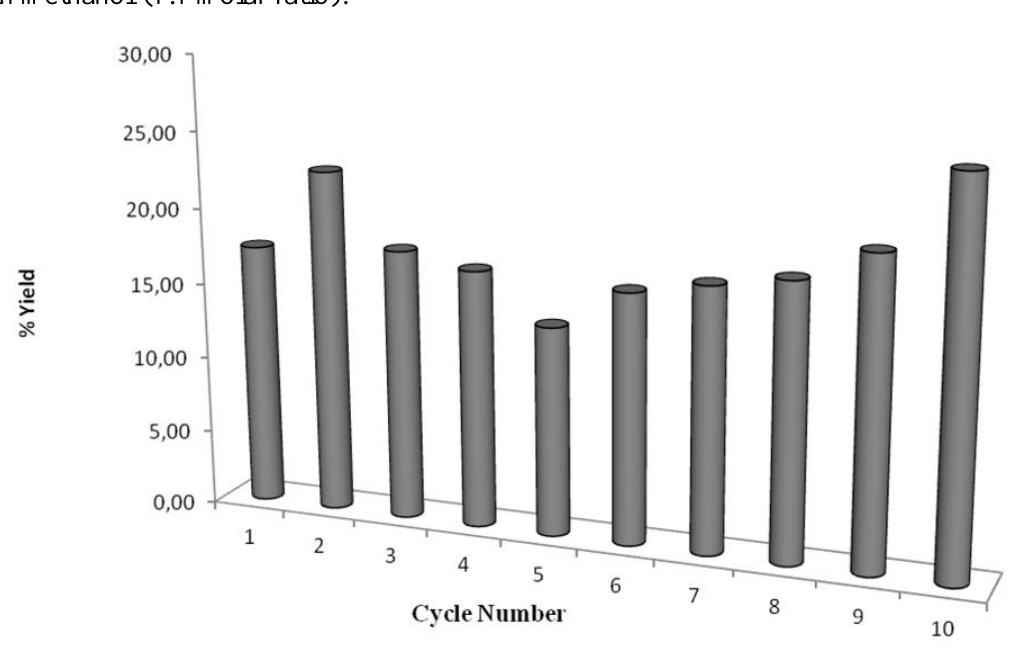
Figure 8. Recyclability of CalB immobilized on styrenic support expressed as the percentage of methyl oleate formed after 4 h at 30 °C in the transesterification of triolein with methanol (1:1 molar